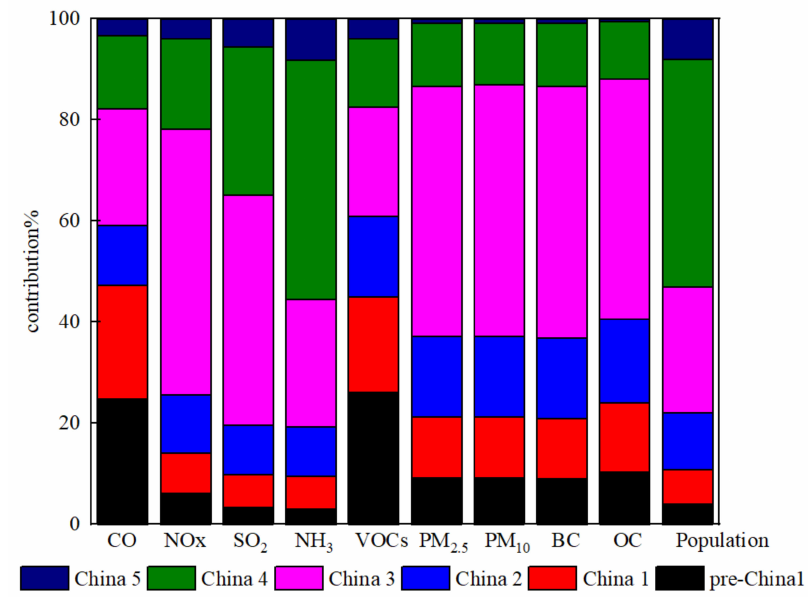
Figure 4. Emission contributions of vehicles with different emission